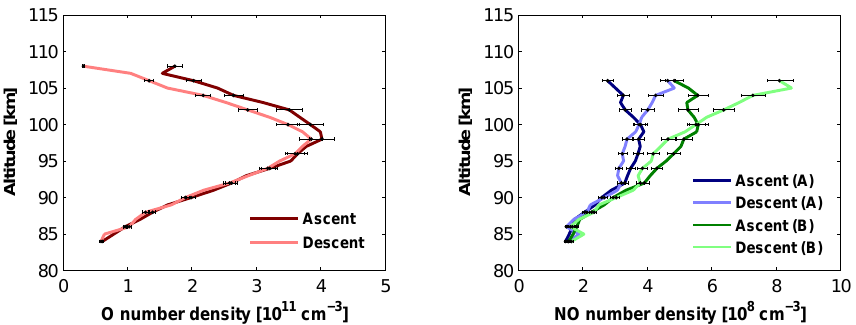
Fig. 4. Left panel: the retrieved O profiles from the O 2 A-band ascent and descent emission measurements. The error bars show the possible errors in the retrieval due to the uncertainties of the rate coefficients. Right panel: the inferred NO concentrations plotted for the “case A” (with a temperature independent two-body reaction) in blue colours and “case B” (with a temperature dependent two-body reaction) in green colours. The darker colour profiles are the ascent measurements and the lighter colour profiles are the descent measurements. The error bars show also here the possible errors in the retrieval due to the uncertainties of the rate coefficients in the O retrieval.